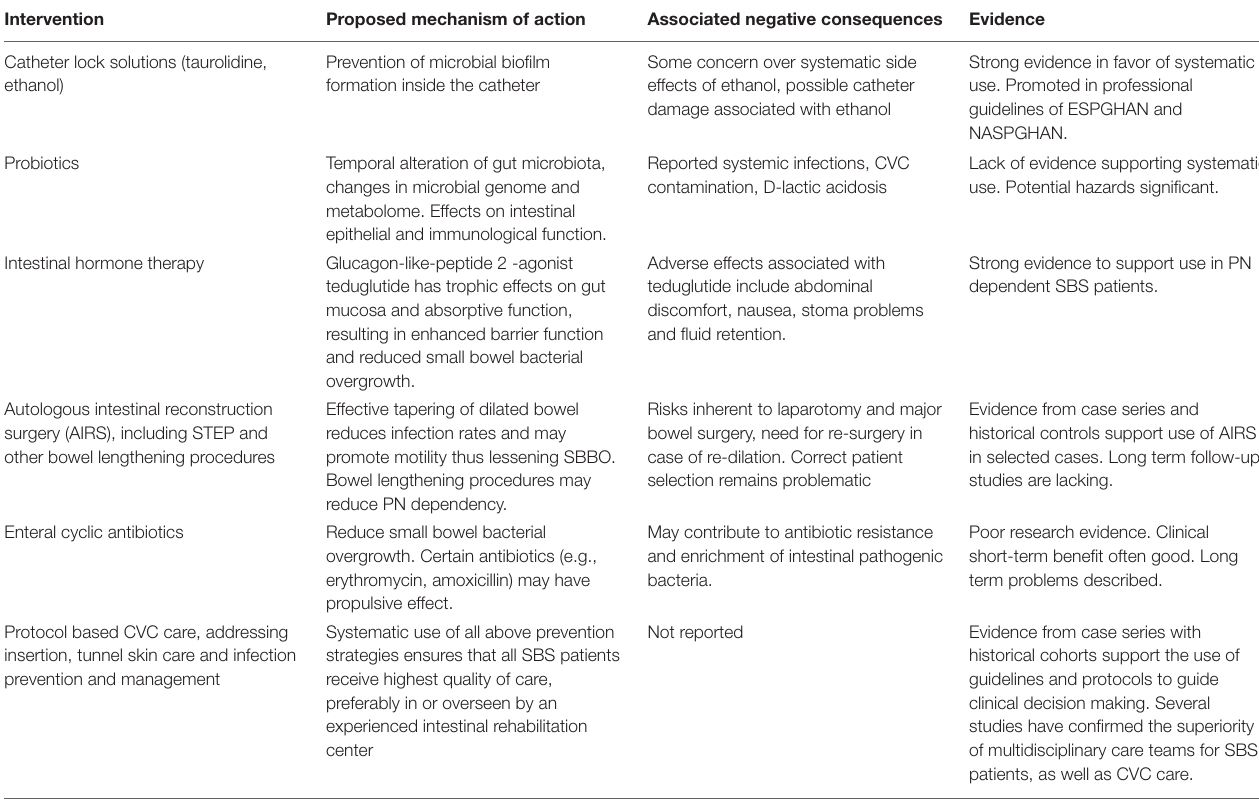
TABLE 1 | Infection prevention strategies for pediatric patients with short bowel syndrome